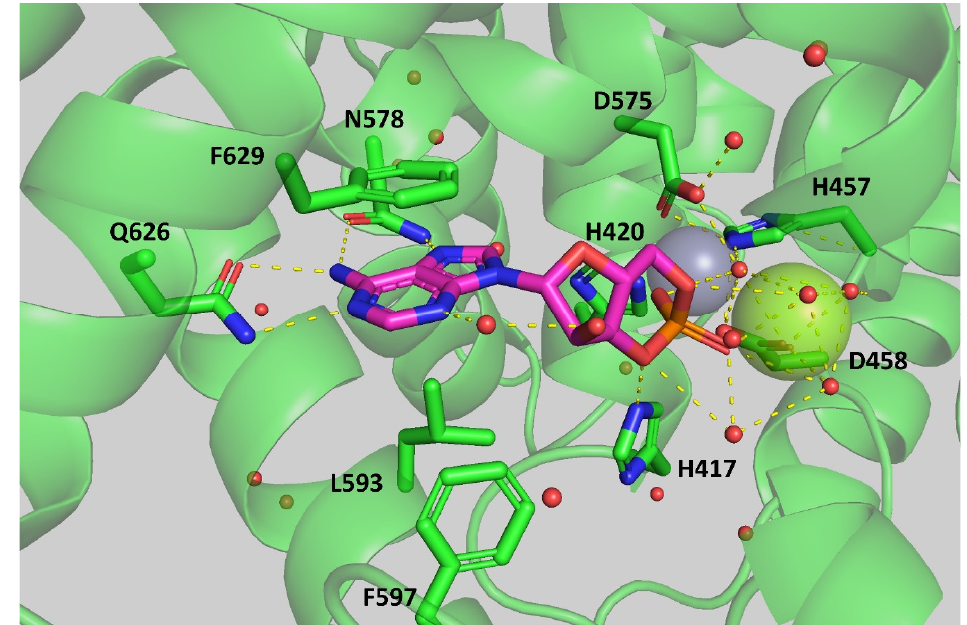
Figure 3. Interaction of the catalytic domain of SmPDE4A with cAMP (purple) as found in the chain A of 6FG5. The cyclic phosphate group interacts with the Mg 2+ (green sphere) and Zn 2+ (grey sphere) ions and interferes with the water (red dots) network on the left side of the substrate binding pocket.